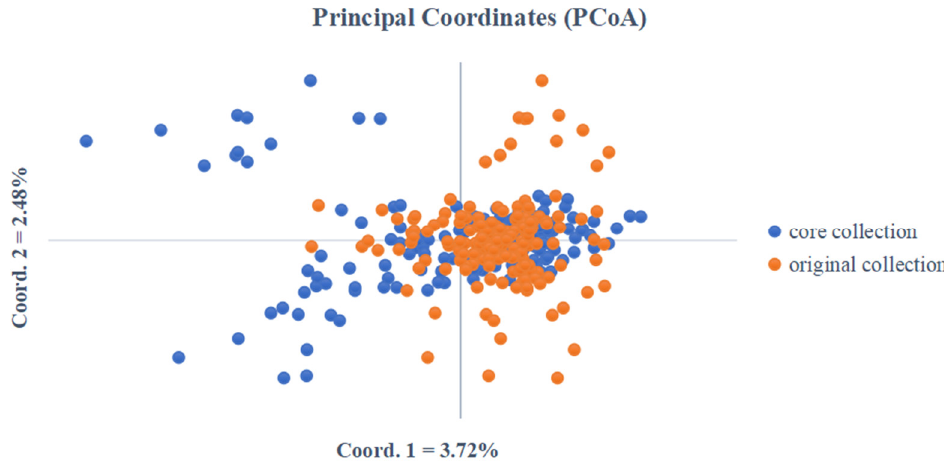
Figure 7. Principal coordinate distribution of the C. hystrix core collection and original collection.